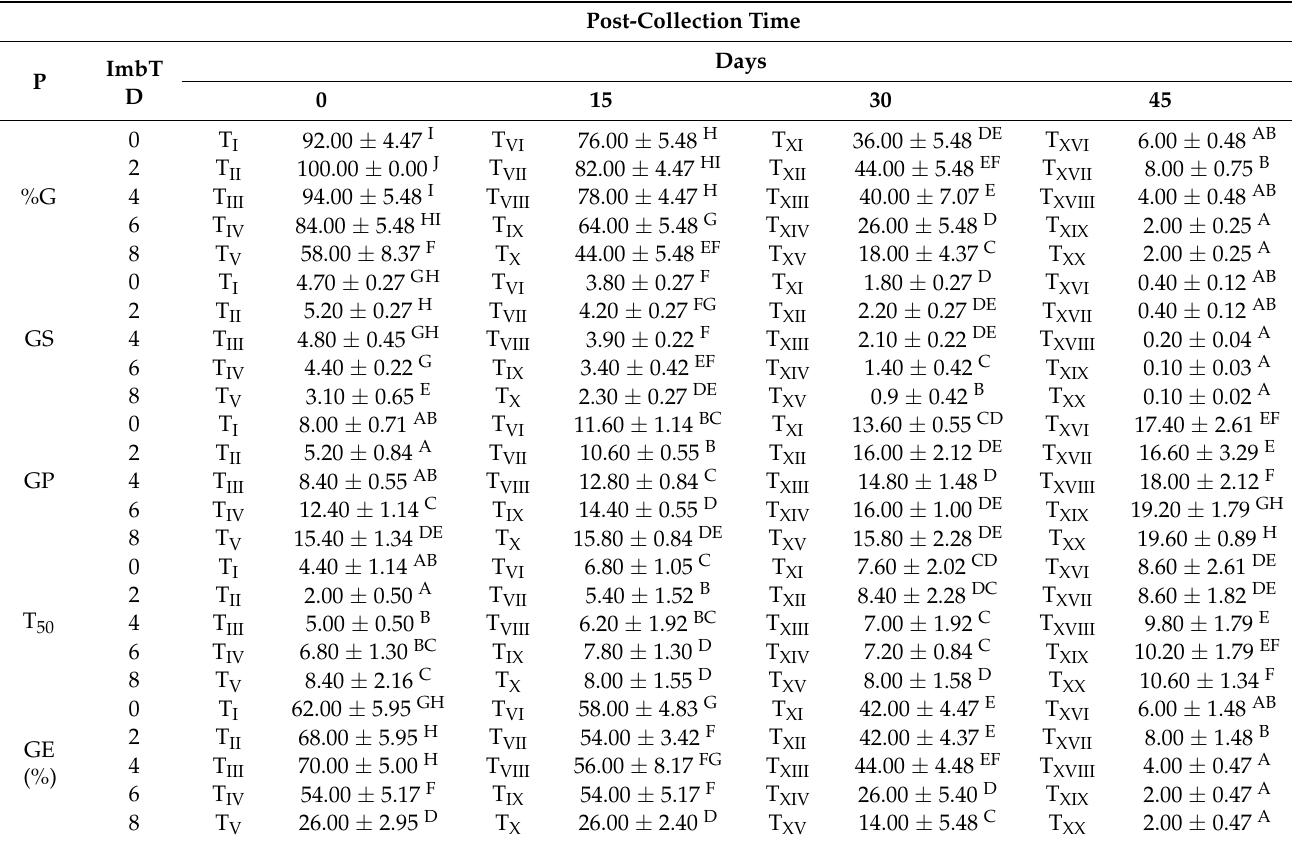
Table 2. Effects of the imbibition time (ImbT) and post-collection time on germination parameters of germination percentage, germination speed, germination period, T 50 and germination